Question: In one sentence, what is this figure communicating?
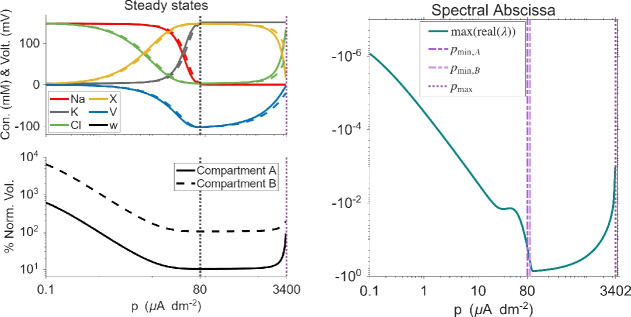
Answer: Steady state values of the ABp system (Equation (28)) and corresponding largest eigenvalues are plotted as functions of the pump rate \documentclass[12pt]{minimal} \usepackage{amsmath} \usepackage{wasysym} \usepackage{amsfonts} \usepackage{amssymb} \usepackage{amsbsy} \usepackage{mathrsfs} \usepackage{upgreek} \setlength{\oddsidemargin}{-69pt} \begin{document}$$p$$\end{document} p . As shown in the right panel, all eigenvalues are negative for any given \documentclass[12pt]{minimal} \usepackage{amsmath} \usepackage{wasysym} \usepackage{amsfonts} \usepackage{amssymb} \usepackage{amsbsy} \usepackage{mathrsfs} \usepackage{upgreek} \setlength{\oddsidemargin}{-69pt} \begin{document}$$p$$\end{document} p , indicating that the steady states are locally stable. The vertical lines mark \documentclass[12pt]{minimal} \usepackage{amsmath} \usepackage{wasysym} \usepackage{amsfonts} \usepackage{amssymb} \usepackage{amsbsy} \usepackage{mathrsfs} \usepackage{upgreek} \setlength{\oddsidemargin}{-69pt} \begin{document}$$p_{\min ,j}$$\end{document} p min , j and \documentclass[12pt]{minimal} \usepackage{amsmath} \usepackage{wasysym} \usepackage{amsfonts} \usepackage{amssymb} \usepackage{amsbsy} \usepackage{mathrsfs} \usepackage{upgreek} \setlength{\oddsidemargin}{-69pt} \begin{document}$$p_{\max }$$\end{document} p max , corresponding to the pump rates at which the steady state volume reaches its minimum and to the largest value of \documentclass[12pt]{minimal} \usepackage{amsmath} \usepackage{wasysym} \usepackage{amsfonts} \usepackage{amssymb} \usepackage{amsbsy} \usepackage{mathrsfs} \usepackage{upgreek} \setlength{\oddsidemargin}{-69pt} \begin{document}$$p$$\end{document} p for which steady states exist, respectively. Both set of axes are shown on a logarithmic scale. All other parameters are fixed at their default values given in Tables 1 – 4 (color figure online)